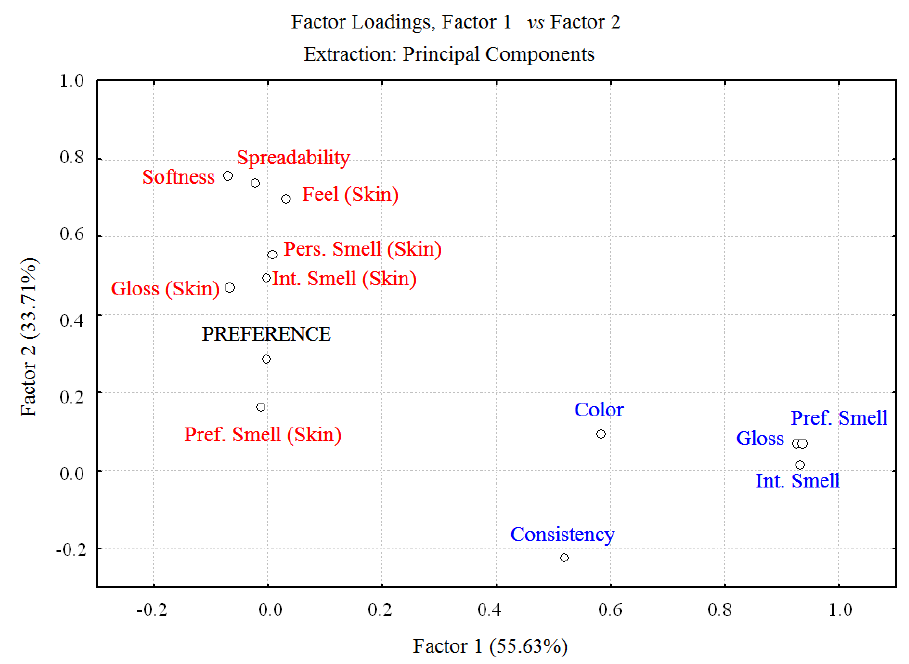
Figure 4. Principal component analysis showing the relation among sensory attributes and the global preference of cream.